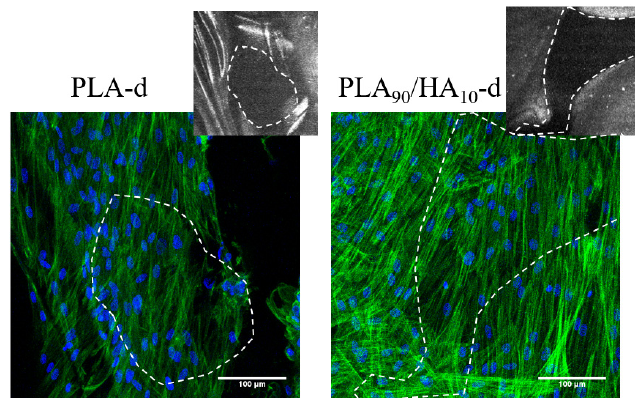
Figure 8. Confocal microscopy visualization of MSCs cultured on PLA-d and PLA 90 /HA 10 -d for 21 days, labeled with Phalloidin ® (green; cytoskeleton) and DAPI (blue; nucleus). Scale bars = 100 µm; insert = Scaffolds visualization in reflexion mode. The white dotted delimitations highlight the corresponding scaffold pores.